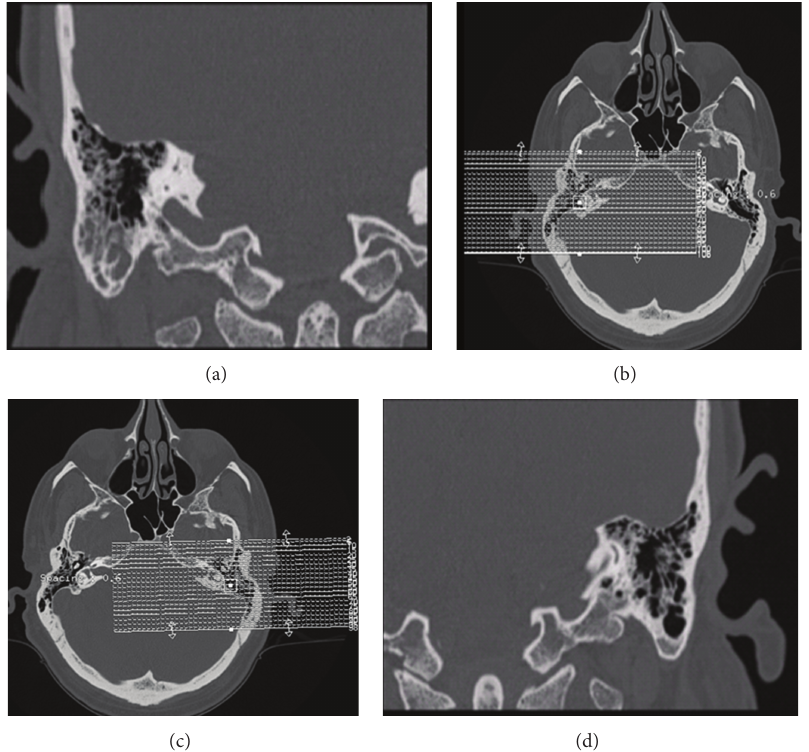
Figure 5: Computer tomography of temporal bones showing marked inflammatory changes in right mastoid cells ((a), (b)) and mild inflammatory changes seen in left mastoid cells ((c),